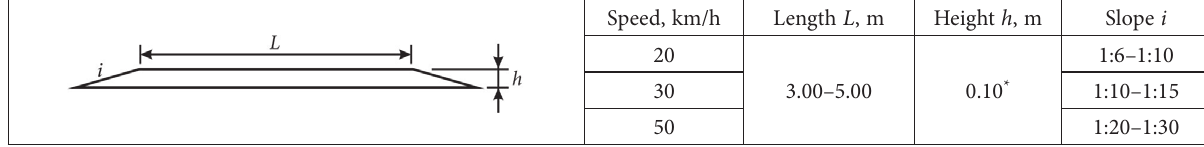
Table 1. Dimensions of trapezoidal speed humps depending on the speed according to the R ISEP